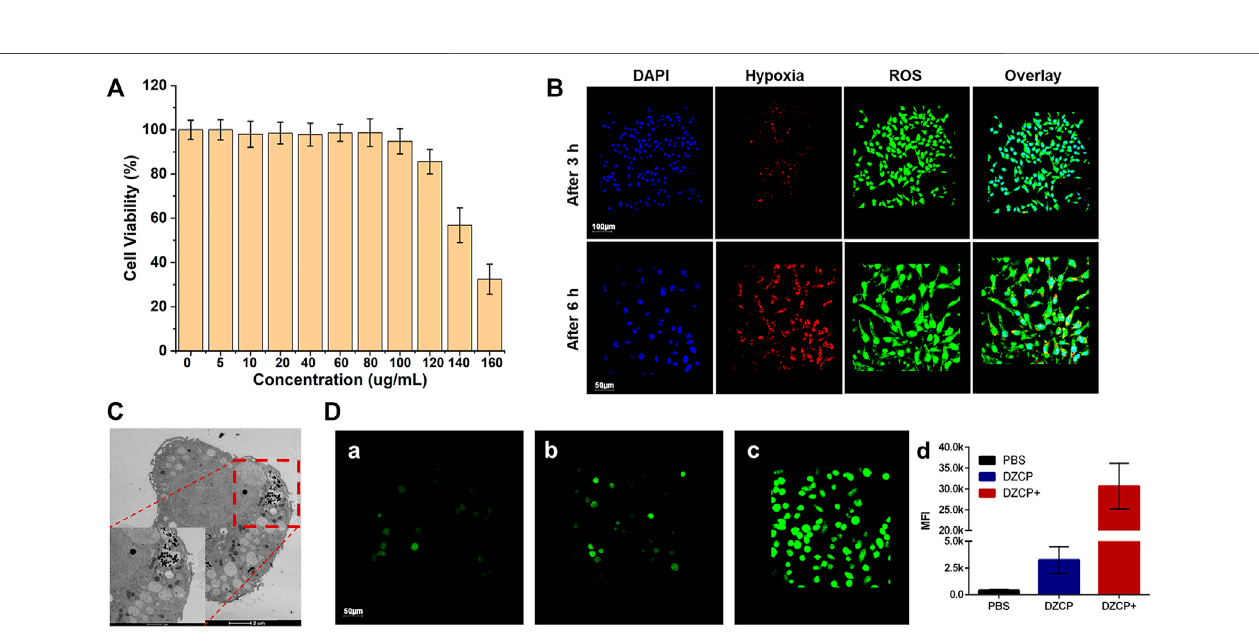
Frontiers in Materials |